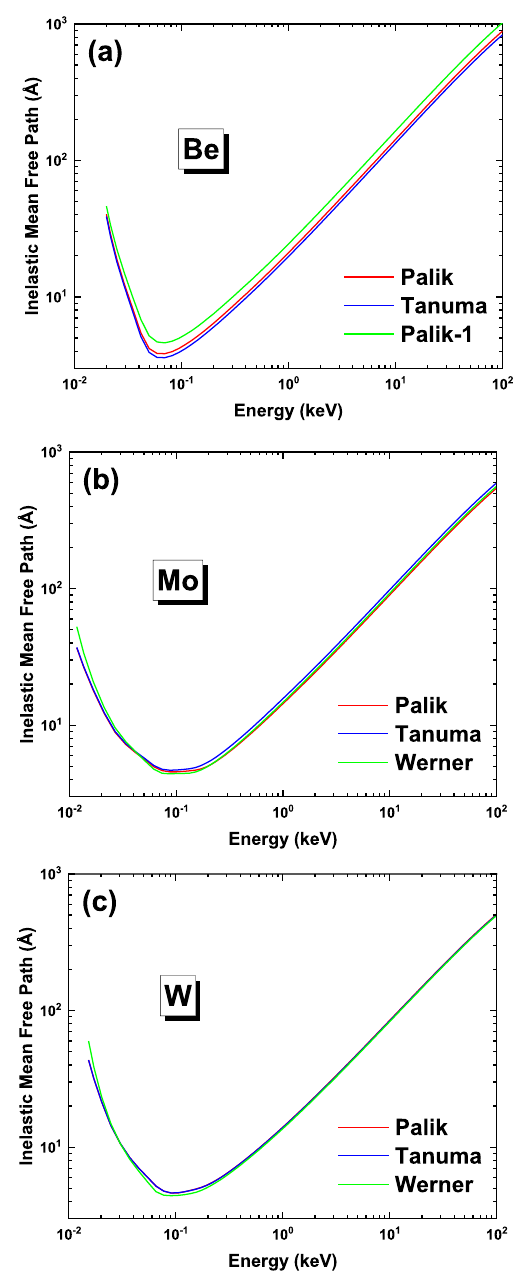
Figure 3. The inelastic mean free path for ( a ) Be, ( b ) Mo and ( c ) W, which are calculated from the ELFs in Fig.